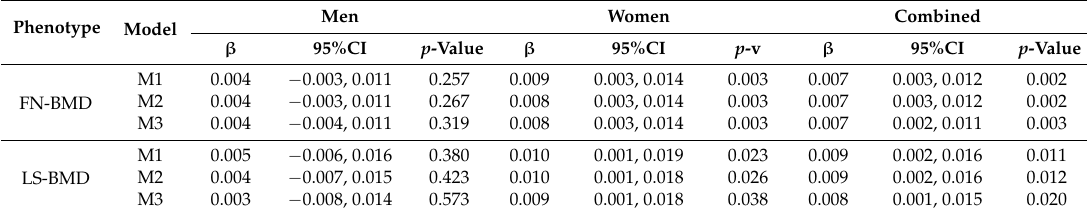
Table 3. Association between rs11614913 and BMD phenotypes in participants of the Rotterdam Study. Model 1 (M1) is adjusted for age, cohort, weight, waist to hip ratio (WHR) and height. Model 2 (M2) is adjusted for M1 + alcohol, smoking status (current, former and never smoker) and drugs used for treatment of bone diseases. Model 3 (M3) is adjusted for M2 + estradiol, testosterone, androstenedione, DHEA, and DHEAS. “Combined” was additionally adjusted for